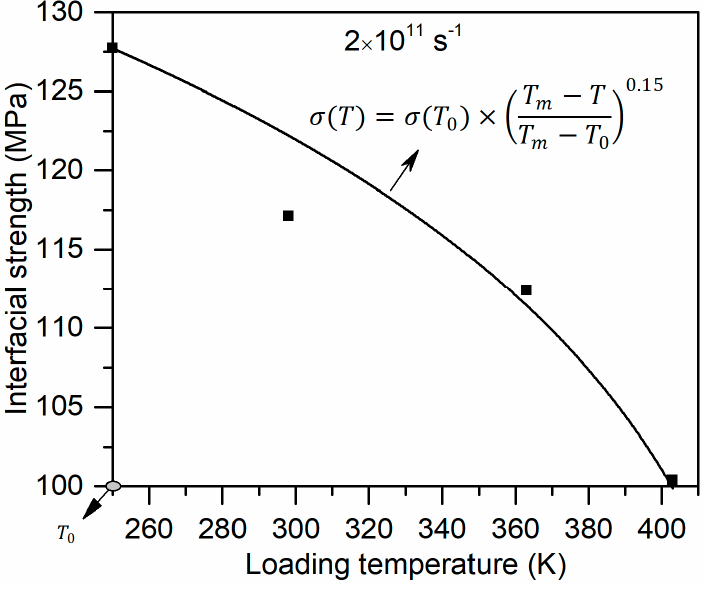
Figure 5. Interfacial residual stress variation during tensile deformation at different loading temperatures.